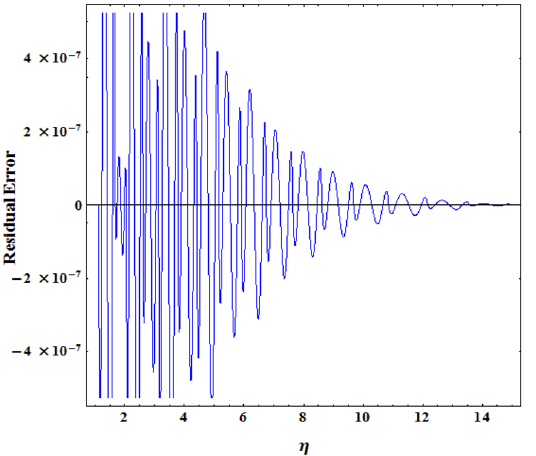
Figure 2. Convergence of residual error for R f ( η j ) at each collocation point— η j , j = 1,2, . . . , N +